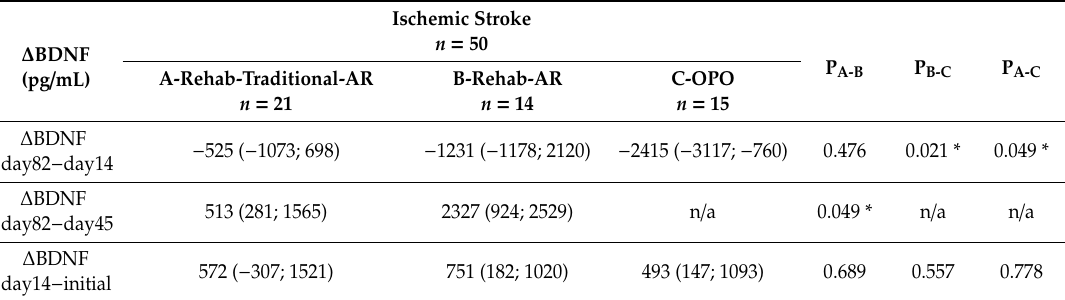
Table 1. ∆ BDNF in the patients groups.